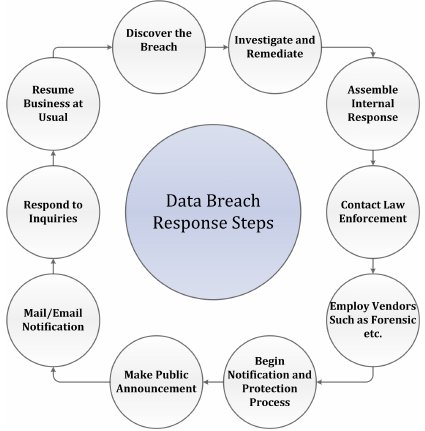
Figure 5. Data breach response steps.